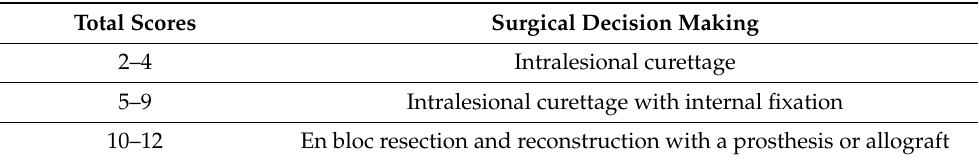
Table 2. Classification for giant cell tumors using the scoring system and surgical decision making proposed by Lun et al.